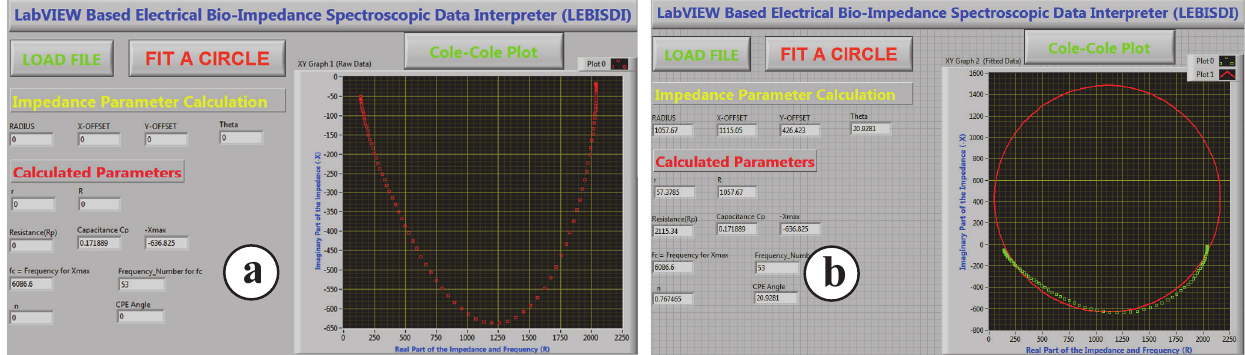
Fig.16: Impedance data fitting and analysis in LEBISDI for a carrot. (a) Before fitting: data loaded. (b) After fitting: data calculated.